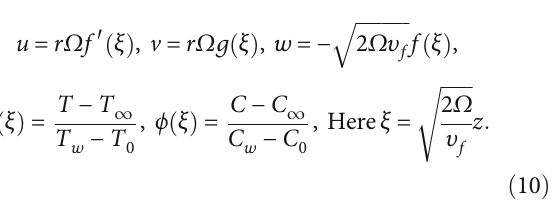
ffiffiffiffiffiffiffiffiffiffiffiffi p Þ indicates the velocity slip 2 Ω / υ f